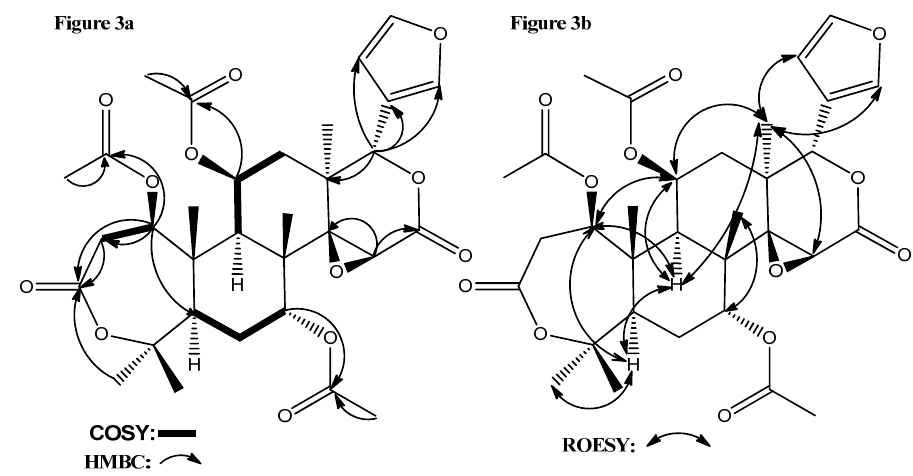
Figure 3. ( a ) Selected HMBC and 1 H- 1 H COSY correlations for 1 ; ( b ) Selected ROESY correlations for 1